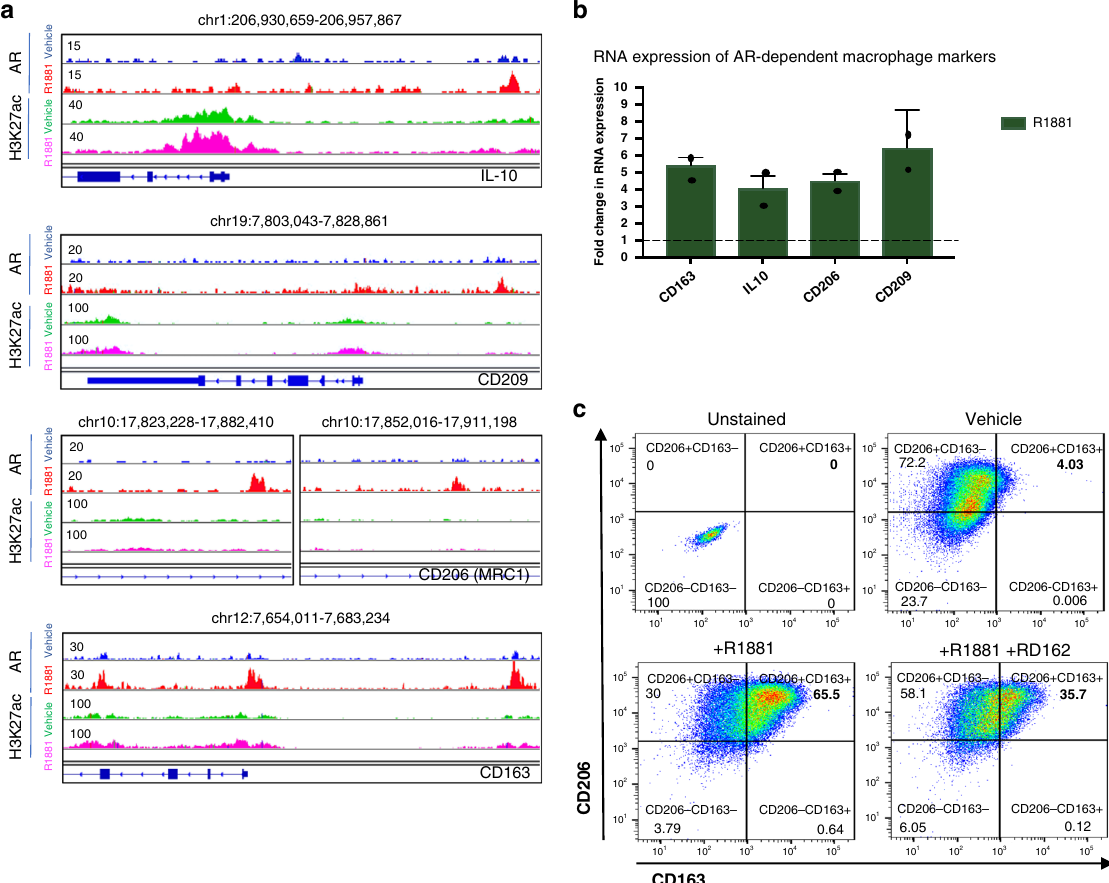
Fig. 8 AR signalling upregulates tissue macrophage-related markers in THP-1 cells. a Snapshot of AR and H3K27ac sites proximal to genes associated with macrophage differentiation in THP-1 PMA;IFNG;LPS cells (IL-10, CD209, CD206 and CD163). Genomic coordinates, gene name and tag counts are indicated. AR peaks in vehicle and R1881 conditions are depicted in blue and red, respectively. H3K27ac peaks in vehicle and R1881 conditions are depicted in green and purple, respectively. Range of normalized read counts is shown on the y axis. b RT-QPCR analysis to assess fold change expression (2 − ΔΔ Ct ) of CD163 , IL-10 , CD206 , CD209 in THP-1 PMA;IFNG;LPS cells upon R1881 stimulation, relative to GAPDH expression and normalized to vehicle conditions (dotted line). Datapoints show mean values and error bars the s.e.m. of two independent experiments with three technical replicates each. Source data are provided as a source data fi le. c Flow-cytometry analysis of surface markers CD206 and CD163 expression in MDM cells. Unstained cells (upper-left) were used as negative control. Twenty-four hrs vehicle stimulated (upper-right), R1881 (10 − 10 M) stimulated (lower-left) and simultaneous R1881 (10 − 10 M) and RD162 (10 − 7 M) stimulated cells (lower-right). The percentage of double positive CD163 + /CD206 + THP-1 PMA;IFNG;LPS cells in the various conditions is represented in bold. Plots are representative for three independent